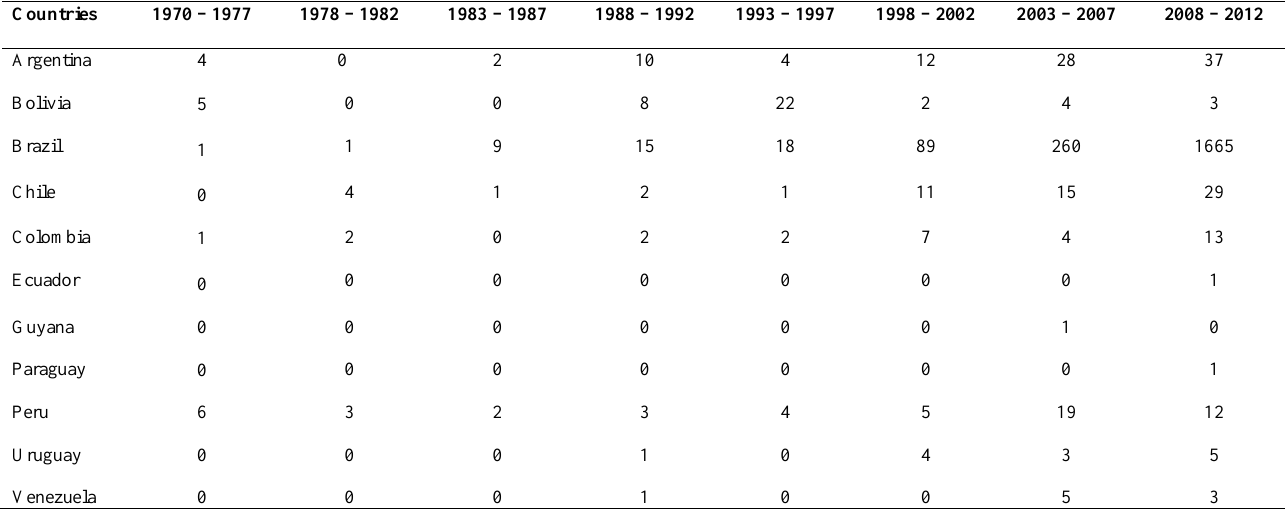
Table 1. Distribution of the number of publications in sports science in South American countries, in the 7-year period from 1970 to 1977, and in 5-year periods from 1978 to 2012.